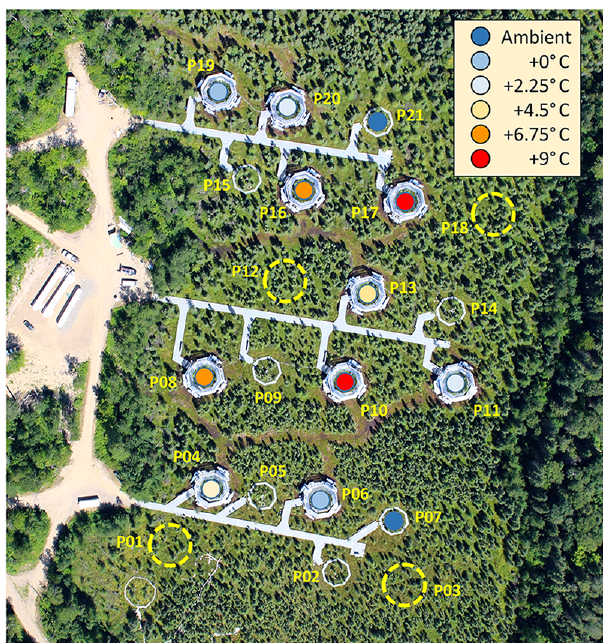
Figure 1. Aerial photograph of the SPRUCE experimental site on 5 August 2015. Plot numbers (1 to 21) and assigned temperature treatments are superimposed on the image. Dashed circles indicated established plot centers for plots that are monitored annually for tree growth. Plots 4, 10, 11, 16 and 19 receive elevated CO 2 . The middle boardwalk is 112m